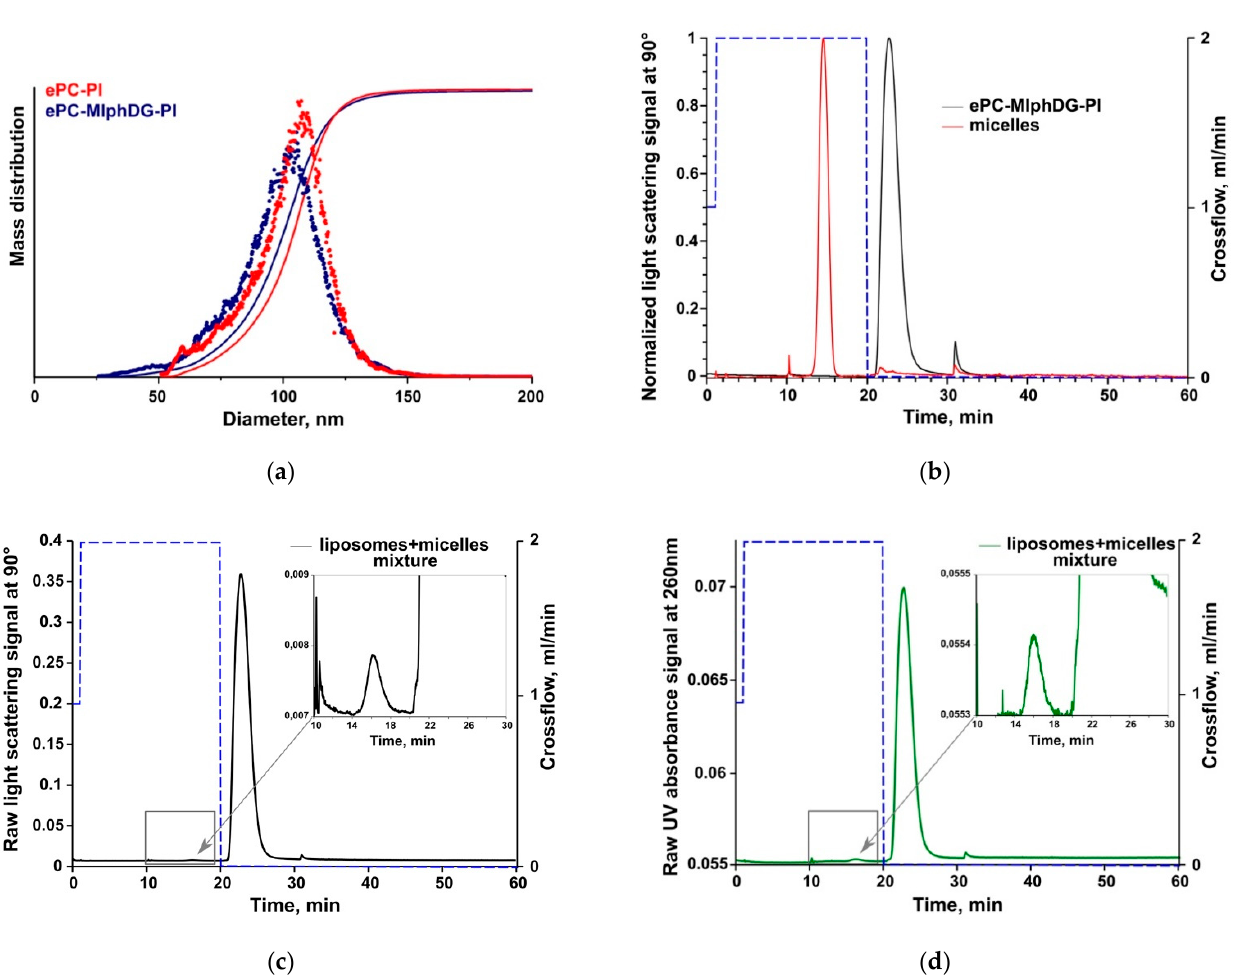
Figure 8. AF4/MALS liposome size distribution ( a ). AF4/MALS elution profile of micelles and ePC–MlphDG–PI liposomes injected separately ( b ) and in mixture (( c , d ) respectively) where the dotted lines show the crossflow conditions. In ( b , c ), the light scattering signals at 90° are shown, in ( d ), the variable wavelength detector (VWD) signal at 260 nm. The first 10 min of analysis is focusing and sample injection. Table 6. Size values by dynamic light scattering (DLS, n = 10) and AF4/multi-angle light scattering (MALS, n = 3). Sample